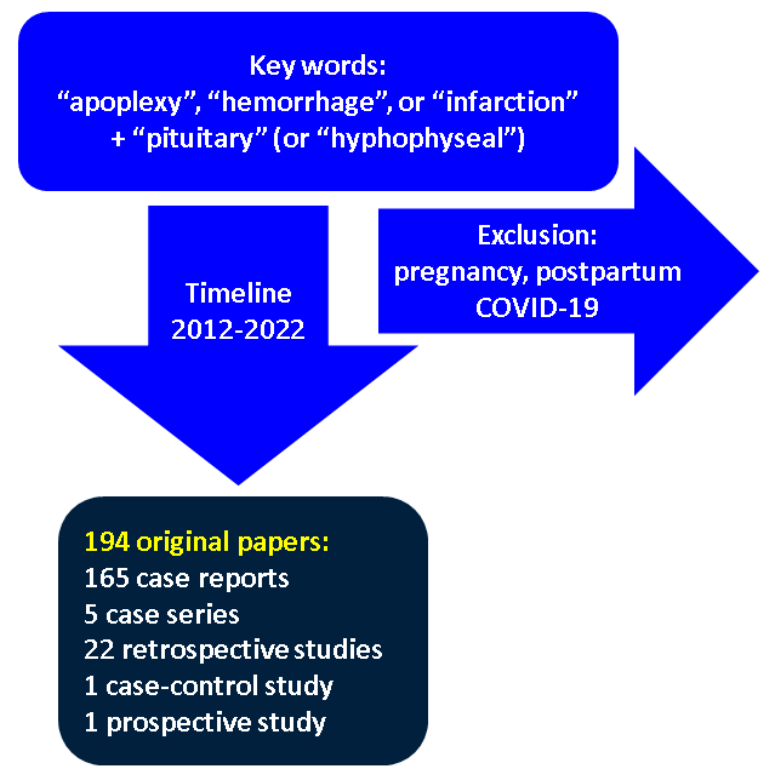
Figure 1. Flowchart according to our methodology.